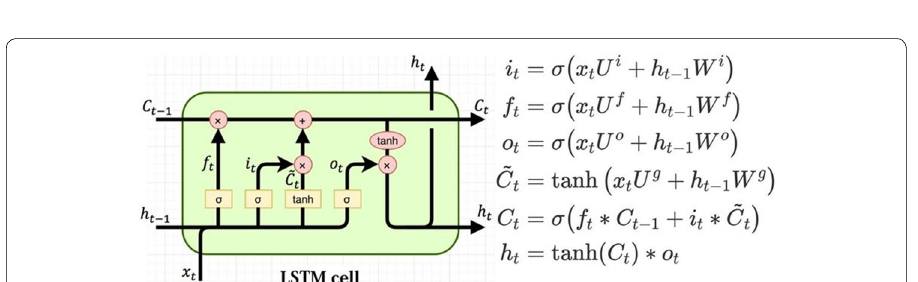
Fig. 5 LSTM cell equations [38]. Shows in details equations of LSTM